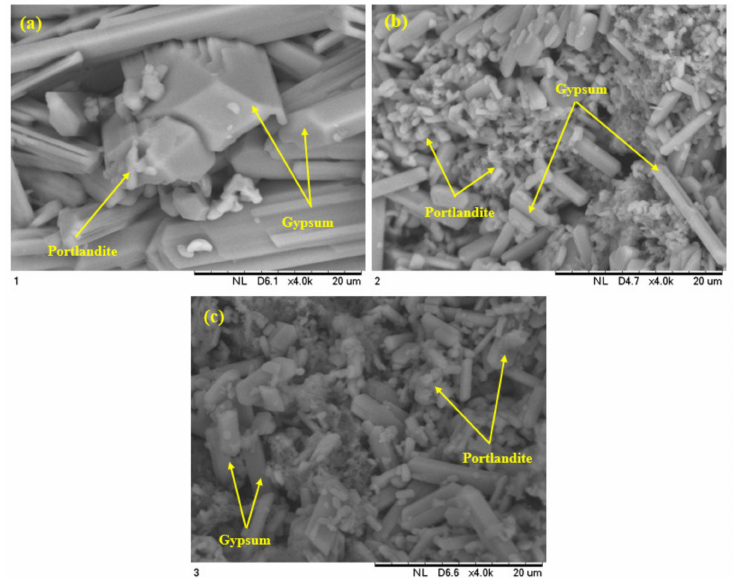
Figure 14. Effect of sulphuric acid solution on surface morphology of modified concrete specimen after 364 days of exposure ( a ) MC1-0-0 ( b ) MC2-50-0 and ( c ) MC4-50-10.